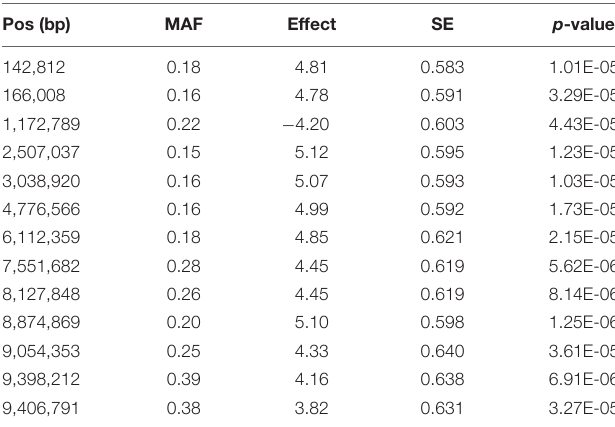
TABLE 5 | Physical position (Pos), minimum allele frequency (MAF), estimated allele substitution effect (in days of survival), standard error (SE), and p -value for the significant SNPs identified in